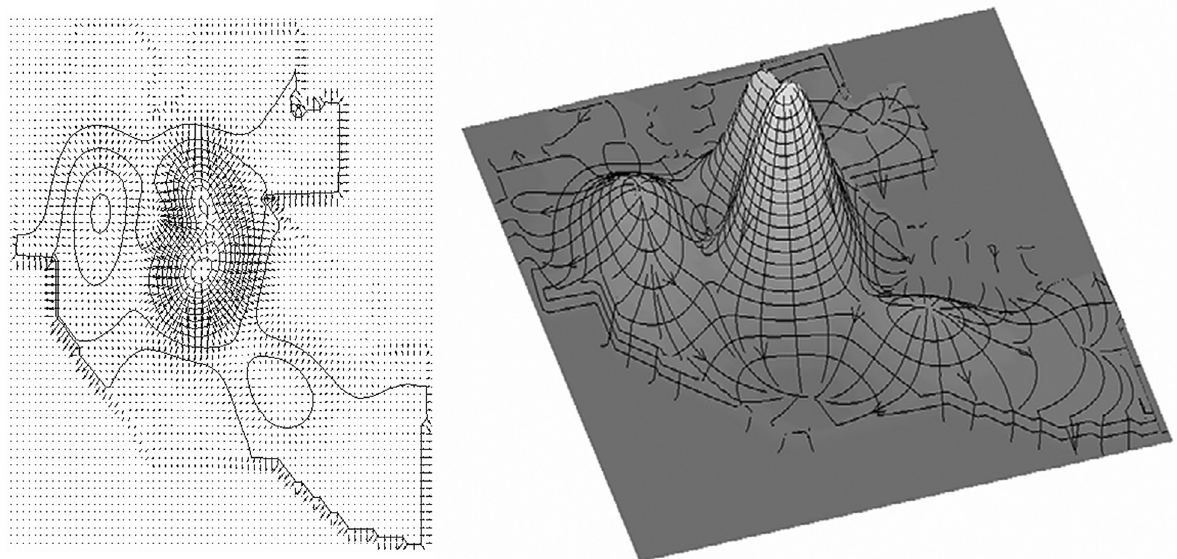
Fig. 3. Density with contours & gradient (left), and perspective with streaklines, showing possible lines of